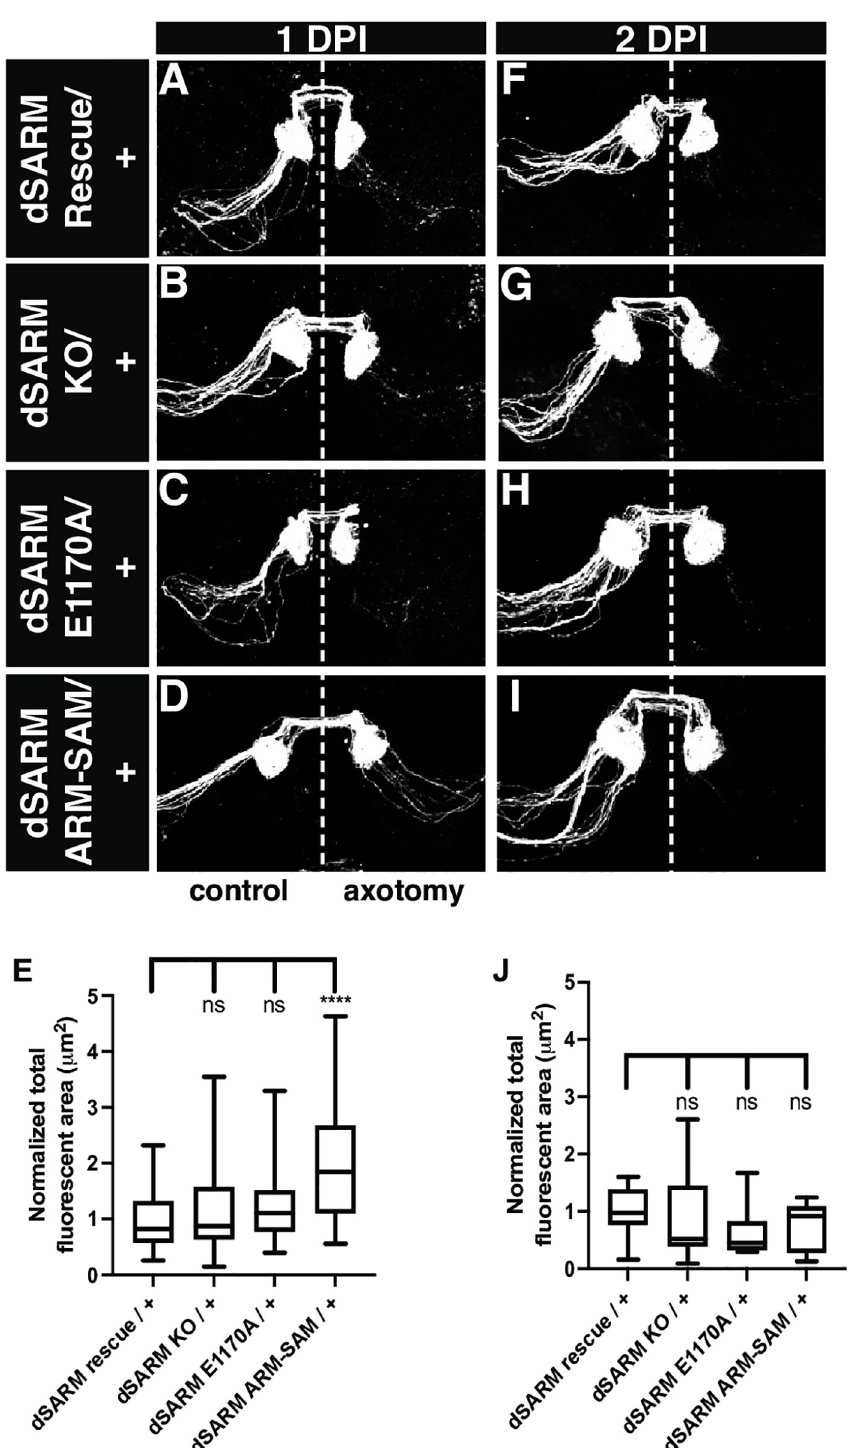
Fig 3. dSARM ARM-SAM has dominant-negative activity following injury. (A-D, F-I) Representative z-projections of OR22a ORNs of the indicated genotypes labeled with anti-GFP. The control side is on the left and the axotomized side is on the right. These animals were injured 7 DPE and analyzed at 1 day (A-D) and 2 days (F-I) post-injury. (E) Quantification of total fluorescent area of debris on injured side at 1 DPI: dSARM Rescue (n = 37): 1.00, dSARM KO (n = 31): 1.16, dSARM E1170A (n = 31): 1.27, and dSARM ARM-SAM (n = 31): 2.07. (J) Quantification of total